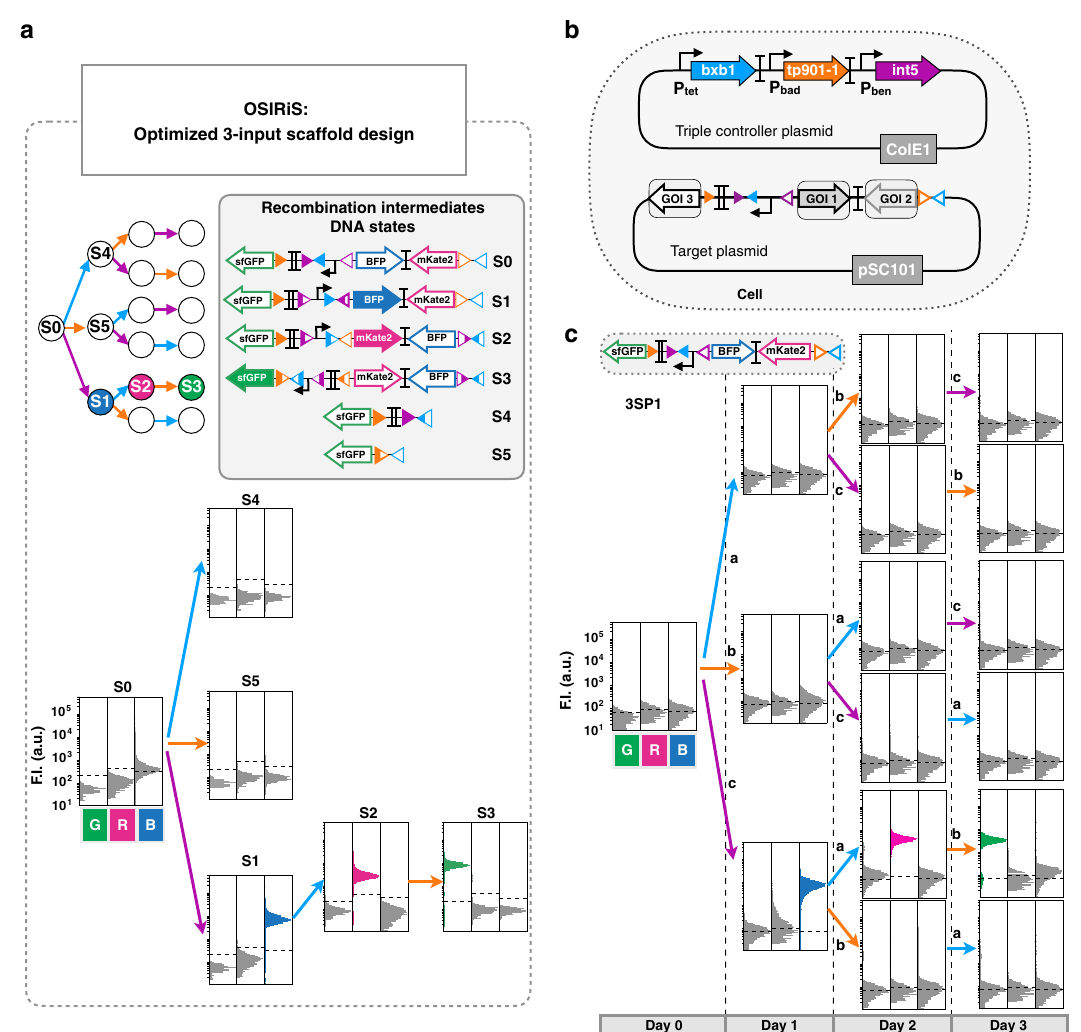
Fig. 5 Characterization of scaffold for 3-input history-dependent programs. a Characterization of the fi nal 3-input scaffold and its recombination intermediates DNA states by fl ow cytometry. We characterized each DNA state by measurement of GFP, RFP, and BFP fl uorescence intensities. Each histogram shows fl uorescent reporters expressed in the different DNA states, from three experiments with three replicates per experiment. A representative example is depicted here. A detailed design for the fi nal 3-input scaffold and fold change measurements can be found in Fig. S8. b Genetic design of the two plasmids used to implement 3-input programs. The triple controller plasmid regulates the expression of Bxb1, TP901-1, and Int5 integrases. The target plasmid corresponds to the 3-input history-dependent scaffold. c Characterization of a 3-input history-dependent scaffold. We cotransformed the 3-input program with the triple controller plasmid. Bxb1 expression is induced by aTc (input a), Tp901 by arabinose (input b), and Int5 by benzoate (input c). The lineage tree for the program and its corresponding genetic DNA device is represented. For characterizing the system, cells were sequentially induced three times for 16 h each, with different order of occurrences of inputs. Each histogram shows fl uorescent reporters expressed in different states. All experiments were performed in triplicate three times on three different days. A representative example is depicted here. Fold change measurements can be found in Fig.